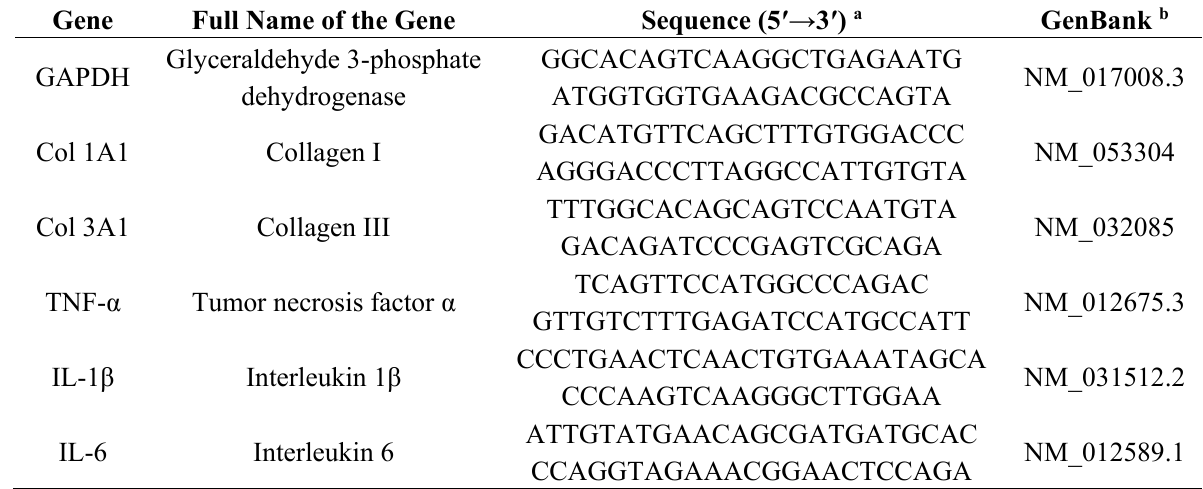
Table 1. The primer sequences used for real-time PCR assay in